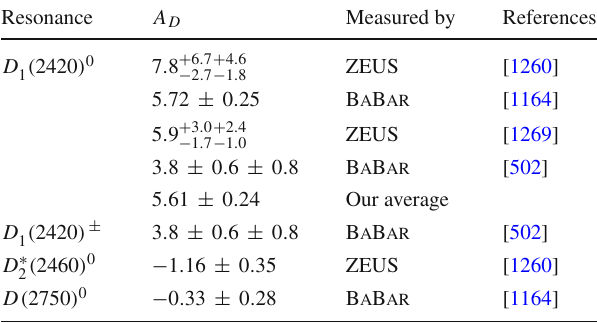
Table 295 Measurements of polarization amplitudes for excited D mesons